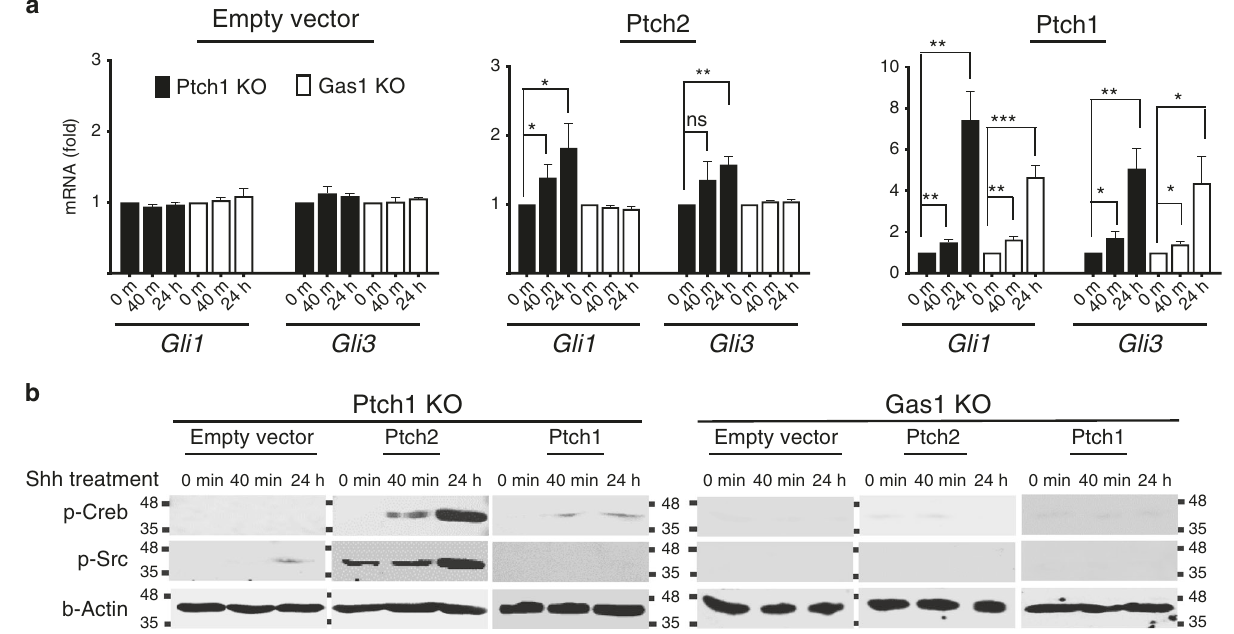
Fig. 8 Ptch2/Gas1 and Ptch1/Boc induce differential Hh downstream signalling responses. a NIH3T3/Cas9 cells with Ptch1 KO or Gas1 KO were transfected with empty vector, Ptch2 or Ptch1 expression construct and stimulated with Shh for 40 min and 24 h. Pro fi le of Gli1 and Gli3 transcripts at the respective time points was analysed by quantitative RT-PCR normalised to Gapdh . Data represent the mean fold induction compared with the untreated control. Error bars represent SD of three independent experiments. Statistical analysis by unpaired t test (* P < 0.05, ** P < 0.01, *** P < 0.001). Dot plots showing individual data points are included in the Source Data fi le. b NIH3T3/Cas9 cells with Ptch1 KO or Gas1 KO were transfected with empty vector, Ptch2 or Ptch1 expression construct and stimulated with Shh as indicated. The signalling responses at the respective time points were analysed by western blotting of total cell lysates using speci fi c antibodies as shown, with b-Actin loading control. Representative blots from three independent experiments are shown. Source data are provided as a Source Data fi